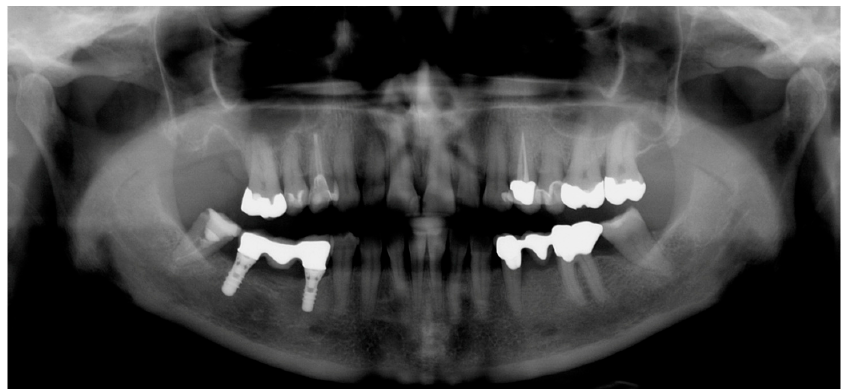
Figure 2. Panoramic radiograph (OPT).